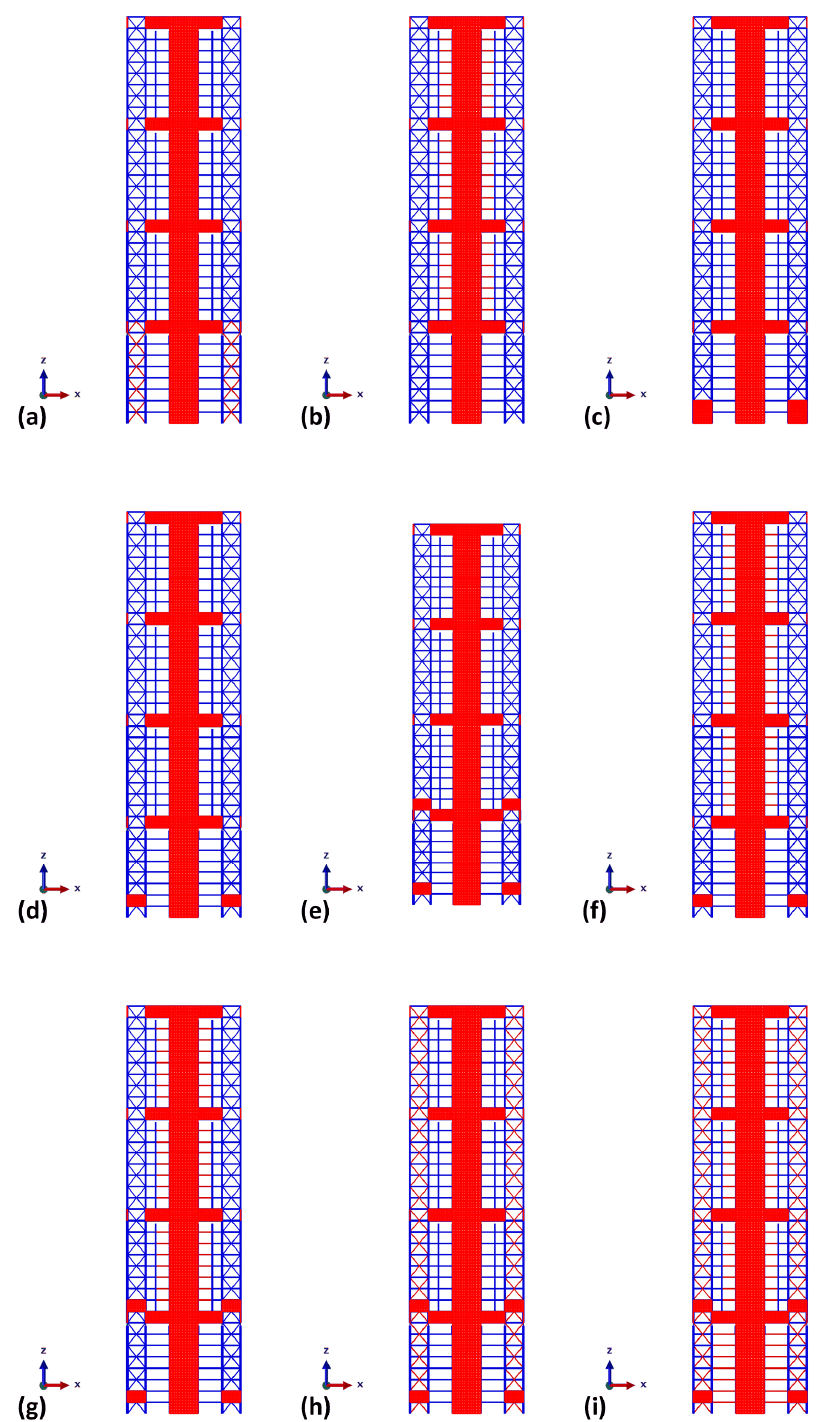
Figure A3. Structural configuration: ( a ) Conf. 25, ( b ) Conf. 26, ( c ) Conf. 27, ( d ) Conf. 28, ( e ) Conf. 29, ( f ) Conf. 30, ( g ) Conf. 31, ( h ) Conf. 32, and ( i ) Conf. 33 .